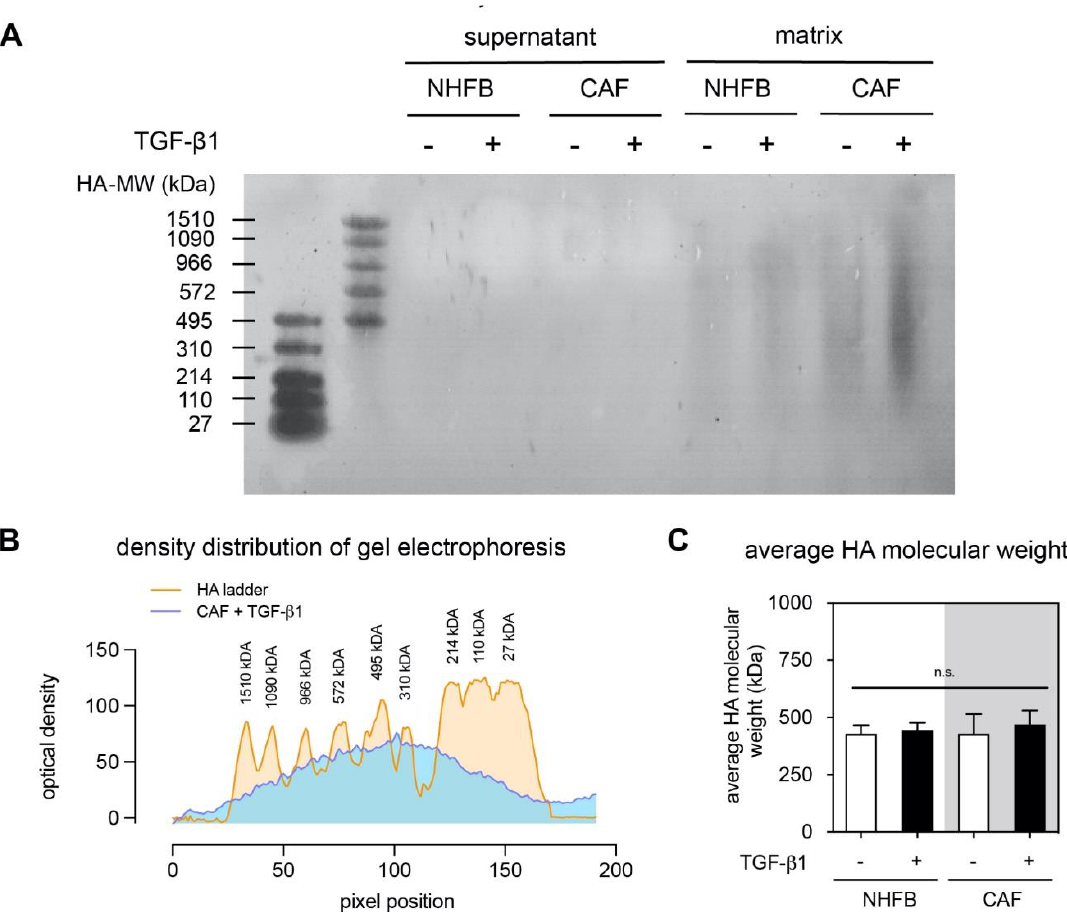
Figure 4. Analysis of HA molecular weight. ( A ) Representative images of electrophoresis gel of supernatant and soluble decellularized collagen matrices of FB and CAF in dependence of TGF- β 1. ( B ) Representative density profile plot of molecular weight distribution of matrix bound HA of CAF treated with TGF- β 1. ( C ) Analysis of the average HA molecular weight of decellularized matrices. Data are presence as mean ± SD; n.s-not significant. All quantitative experiments were performed at least in 3 replicates with fibroblasts and CAF from 3 different donors for each condition.